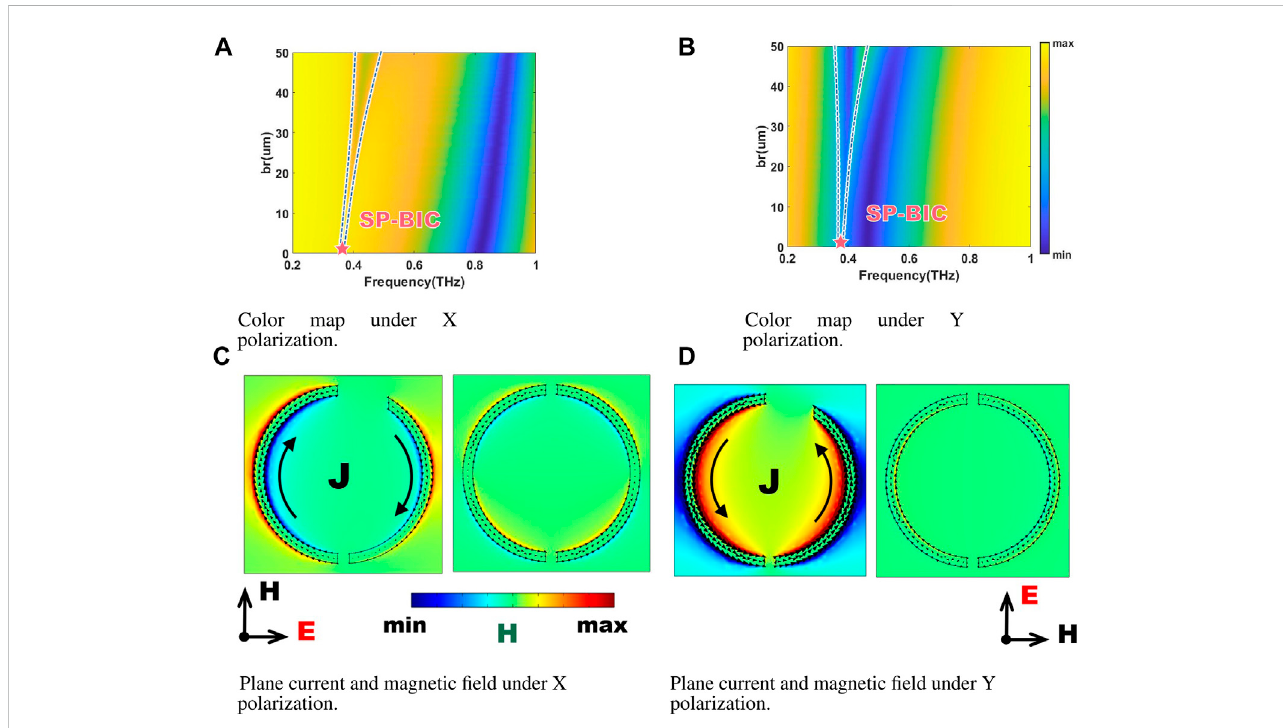
FIGURE 2 The fi gure shows the symmetry-protected BIC (SP-BIC) excited by a single-SRR array. (A) A color map of the simulated transmission spectrum of BIC is drawn by scanning the symmetrical broken gap from 0 um to 50 um with an X-polarized incident wave. (B) A color map of the simulated transmission spectrum of BIC is drawn by scanning the symmetrical broken gap from 0 um to 50 um with a Y-polarized incident wave. (C) The X-O-Y plane current and Z -directionmagnetic fi eldintensitycorrespondtoquasi-BICandBICmodesunderXpolarization. (D) TheX-O-Yplanecurrentand Z -directionmagnetic fi eld intensity correspond to quasi-BIC and BIC modes under Y